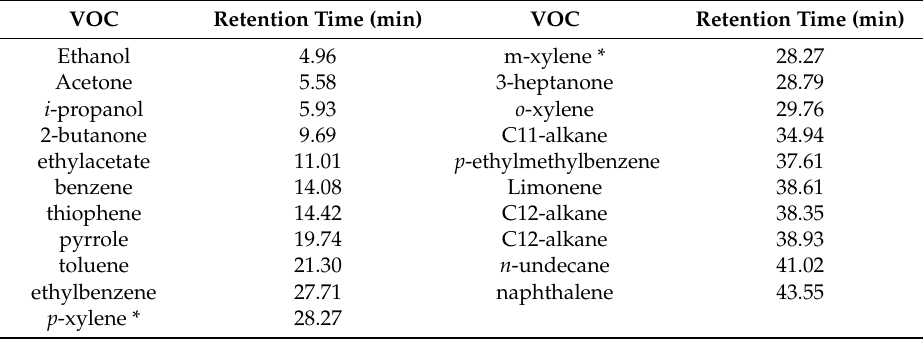
Table 1. Volatile organic compounds (VOCs) detected and listed according to gascromatographic elution